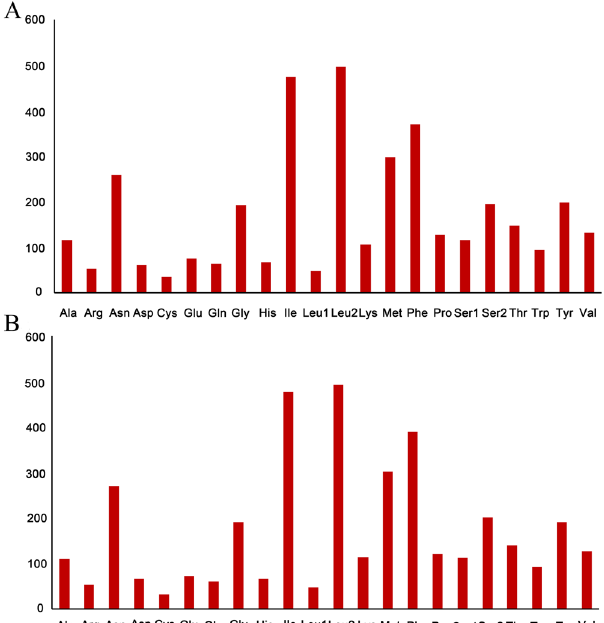
Figure 4. Amino acid composition in the mt genomes of A . rubiginosa ( A ) and R . menciana ( B